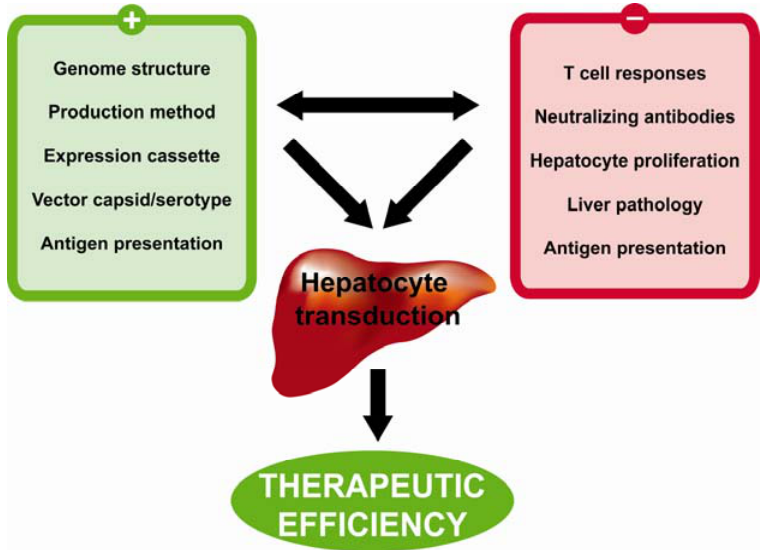
Figure 2. Key determinants of efficient AAV-mediated hepatocyte-directed gene transfer and of persistent transgene expression in parenchymal liver cells. Efficient gene